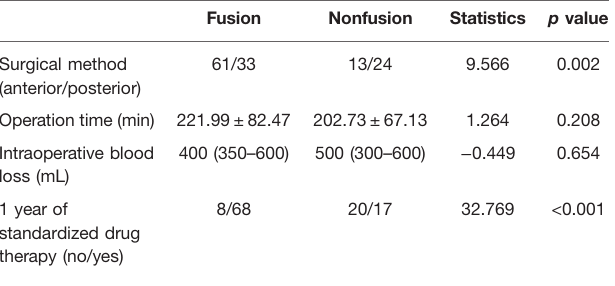
TABLE 3 | Comparison of intraoperative and follow-up data between the two groups.